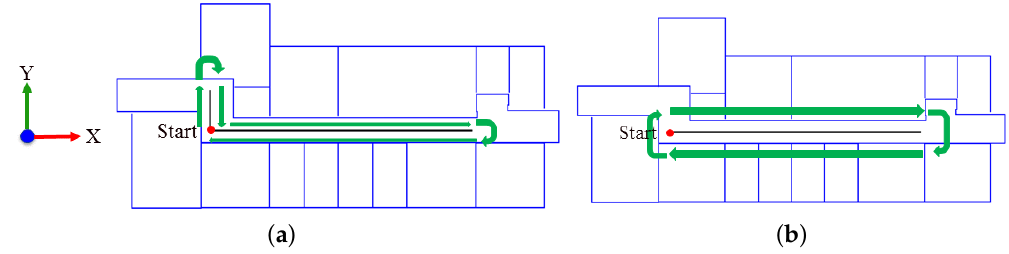
Figure 8. Two routes in the testbed. The red dot indicates the starting location and the black lines represent the ground truth: ( a ) Route 1 contains two U-turns and one left turn; and ( b ) Route 2 includes three U-turns.